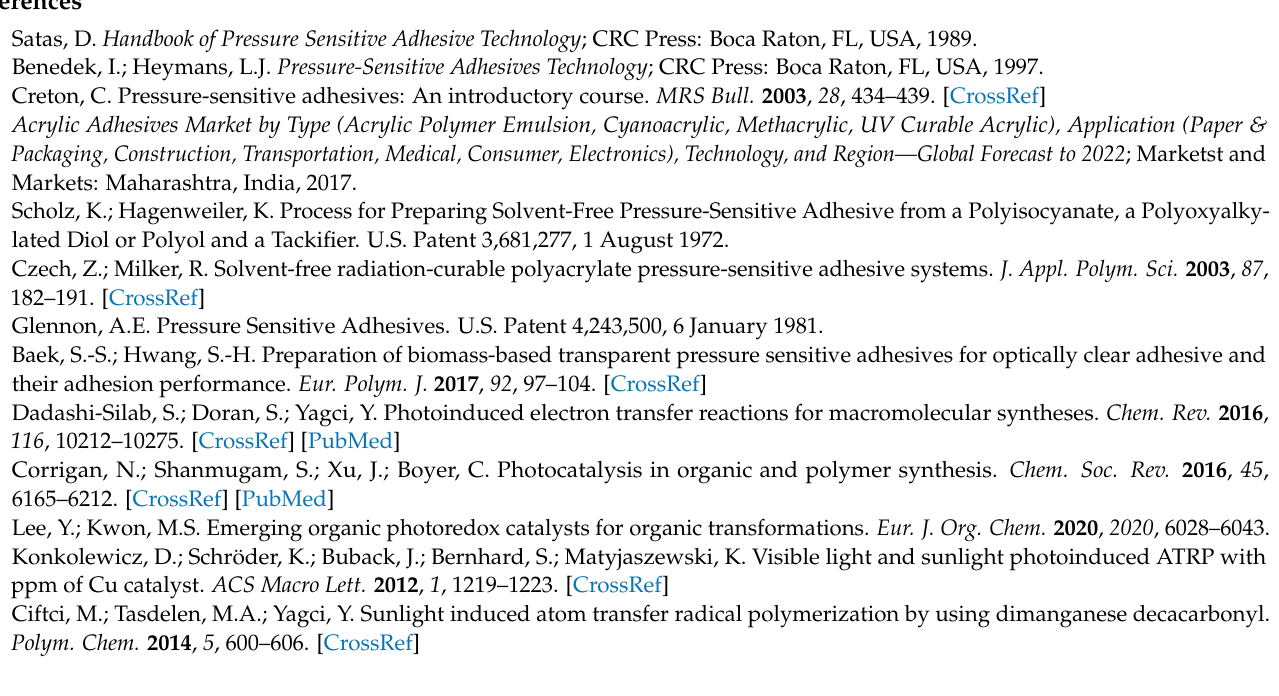
spectrum and PL intensity of 4DP-IPN. Figure S7: Calculation of conversion at film curing (FTIR). Figure S8: Method for the evaluation of the gel contents. Figure S9: Method for the evaluation of the adhesive properties. Figure S10: Lap shear strength. Figure S11: Characterizations of a repre- sentative sample. Figure S12: Calibration curve of size-exclusion chromatography. Figure S13: DFT calculations. Table S1: Bulk polymerization (supporting). Table S2: Reproducibility. References from Supplementary materials